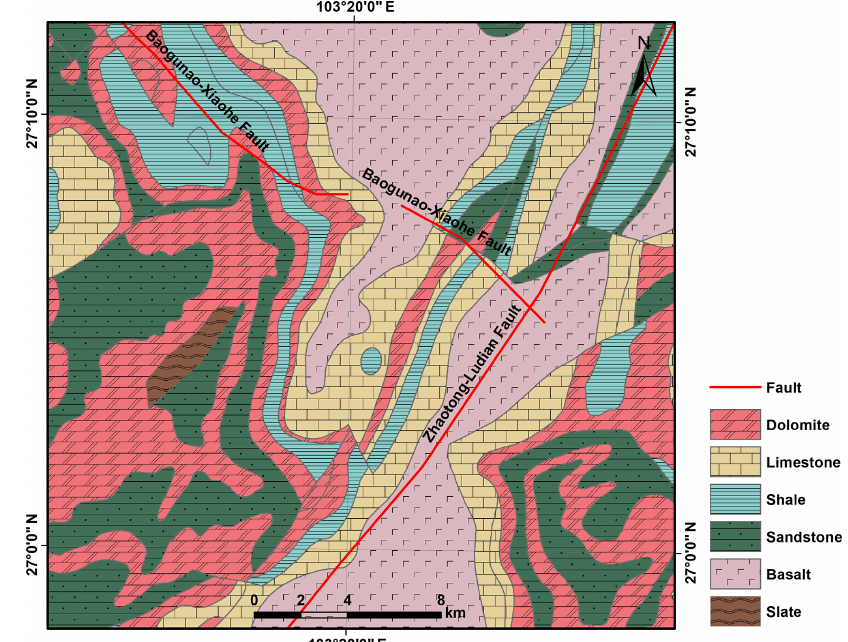
Figure 2. Geological map of the study area showing lithology and faults.